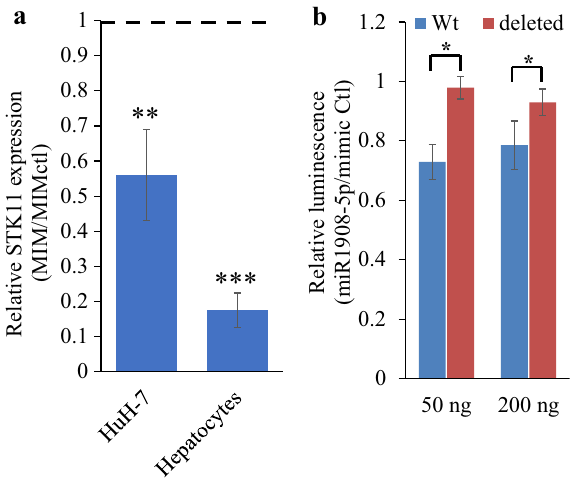
Figure 5. STK11 is a target of miR1908-5p in HuH-7 and hepatocytes. ( a ) Reduced STK11 in HuH-7 and Hepatocytes treated with miR1908-5p or control miRNA for 72 h. RNA was isolated and analyzed by qPCR. Expression was internally normalized to PPIA and results are shown as a ratio of the miR1908-5p treated values divided by the miRNA control values. Control values in HuH-7 were 8.7-fold higher than the Hepatocyte values ( p = 0.0014). Quantification was performed for 3 and 5 independent experiments for HuH-7 and primary hepatocytes, respectively. Error bars represent the 95% C.I. ** p < 0.01; *** p < 0.001; MIM vs MIMctl). Dashed line highlights the control value of 1. ( b ) Reporter assay evaluating the contribution of the STK11 3 ′ UTR, in the presence of MIM or MIMctl . HuH-7 cells were sequentially transfected with miR1908-5p (or mimic ctl) and the indicated amounts of pGL3-PromoterLKB-UTR reporter constructs, either Wt or deleted of putative miR19018-5p binding sites. Quantification of 3 biological replicates (average ± S.D), normalized for each experiment to the mimic control values is shown. Deleted samples values were not statistically significantly different between the miR1908-5p and the mimic control. * p < 0.05 between Wt and deleted constructs.